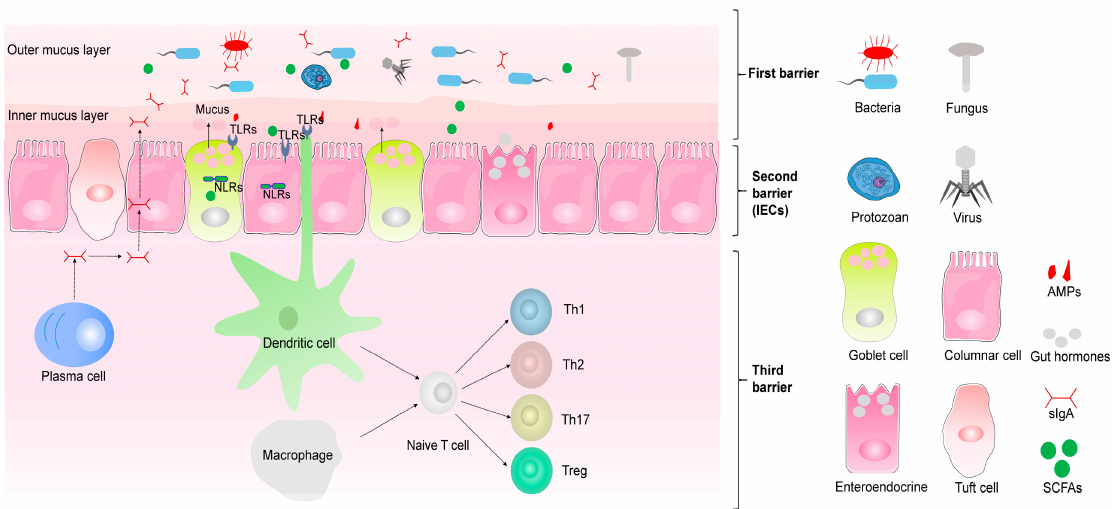
Figure 1. Cross-kingdom biological transmission and communication maintain intestinal homeostasis. Intestinal homeostasis is maintained by three immunological barriers: mucus layer (first barrier), epithelium layer (second barrier), and immune cell layer (third barrier). The mucus layer contains multiple immune mediators such as antimicrobial peptides (AMPs) and secretory immunoglobulin A (SIgA), which limit direct contact between the millions of microorganisms (including bacteria, fungi, viruses, and protists) and the intestinal epithelial cells (IECs). However, microorganisms are responsible for the degradation and digestion of dietary fiber to produce high-energy materials (e.g., short-chain fatty acids [SCFAs]) for the IECs. The IEC layer, which contains multiple pattern recognition receptors (PRRs), such as toll-like receptors (TLRs) and nod-like receptors (NLRs), is the second immunological barrier. It rapidly detects and responds to bacteria that invade the intestinal tissue. Finally, the immune cell layer promotes the monitoring and clearance function of the IECs to limit the access of enteric microbes, thus ensuring that “unlucky” invaders are killed rapidly while also promoting intestinal